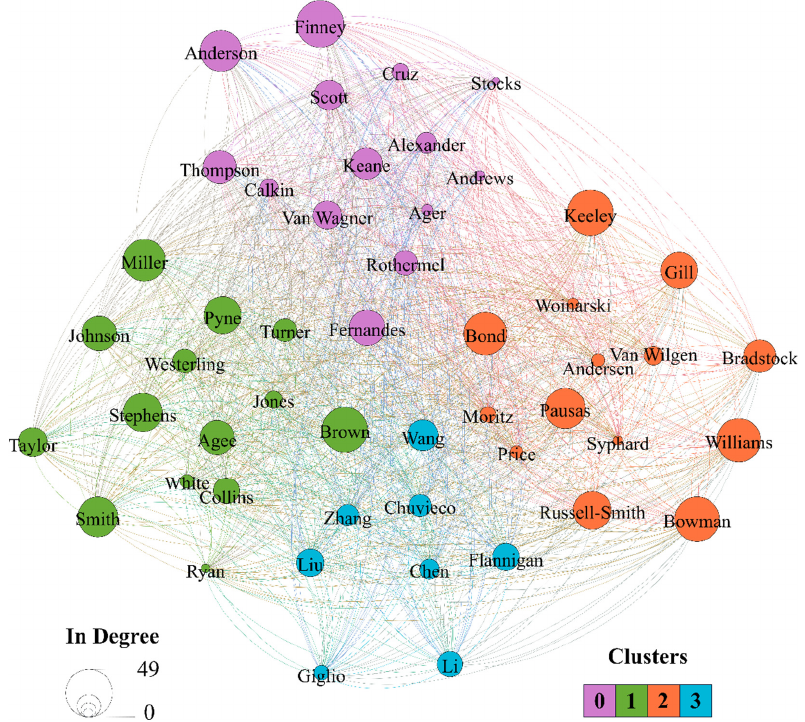
Figure 10. Co-citation network of 50 authors with a high number in co-citations in fire-management research according to Scopus (1973–2021), selected using Bibliometrix. Note: In the case of author co-citation networks, Bibliometrix only provides the author’s